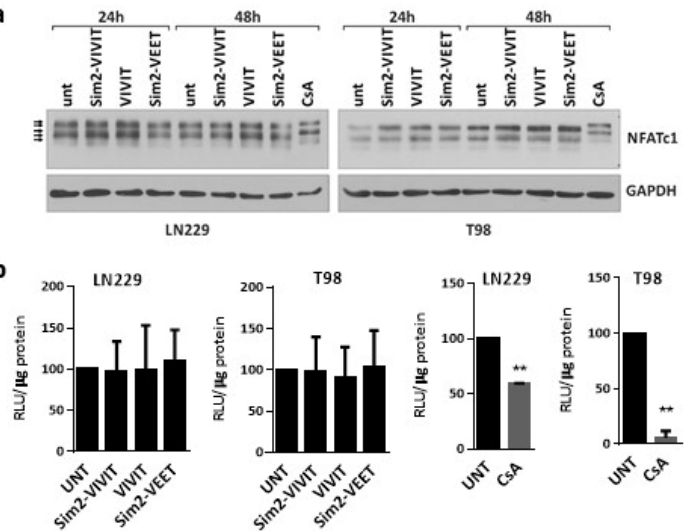
Figure 3. Sim2-VIVIT does not interfere with NFAT signaling in glioma cells. ( a ) Western